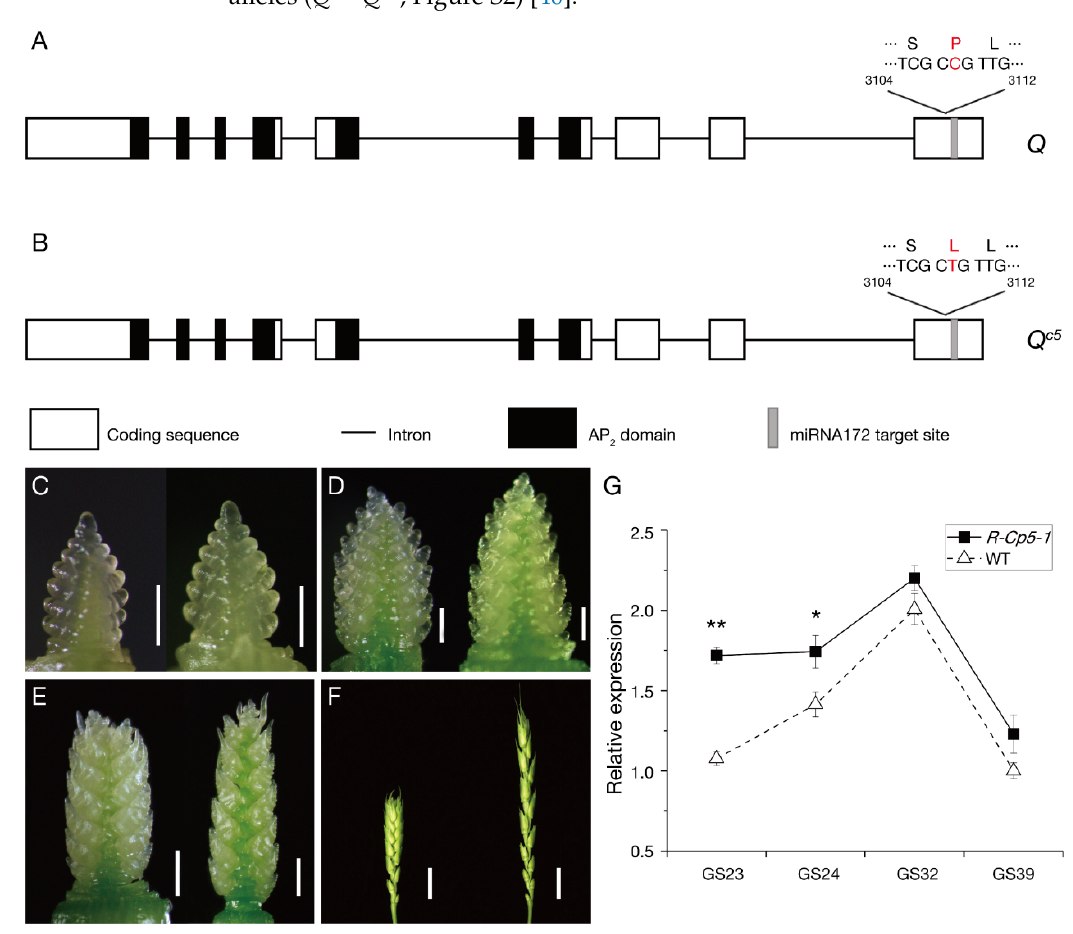
Figure 2. One missense mutation flanking the miRNA172-binding site increased the spike density and the Q c5 expression level. ( A ) and ( B ) Schematic diagrams of the Q and Q c5 alleles. A missense mutation (C in “Roblin” and T in R-Cp5-1 ) changes the 408th residue from proline (P) to leucine (L). ( C – F ) R-Cp5-1 (left) and WT (right) spikes at GS23 ( C ), GS24 ( D ), GS32 ( E ), and GS39 ( F ). Scale bars, 0.05 cm in ( C ) and ( D ), 0.1 cm in ( E ), and 1 cm in ( F ). ( G ) Comparison of the Q and Q c5 transcription levels in spikes at GS23, GS24, GS32, and GS39. Data are presented as the mean ± standard deviation ( n = 3; *, p ≤ 0.05; **, p ≤ 0.01).